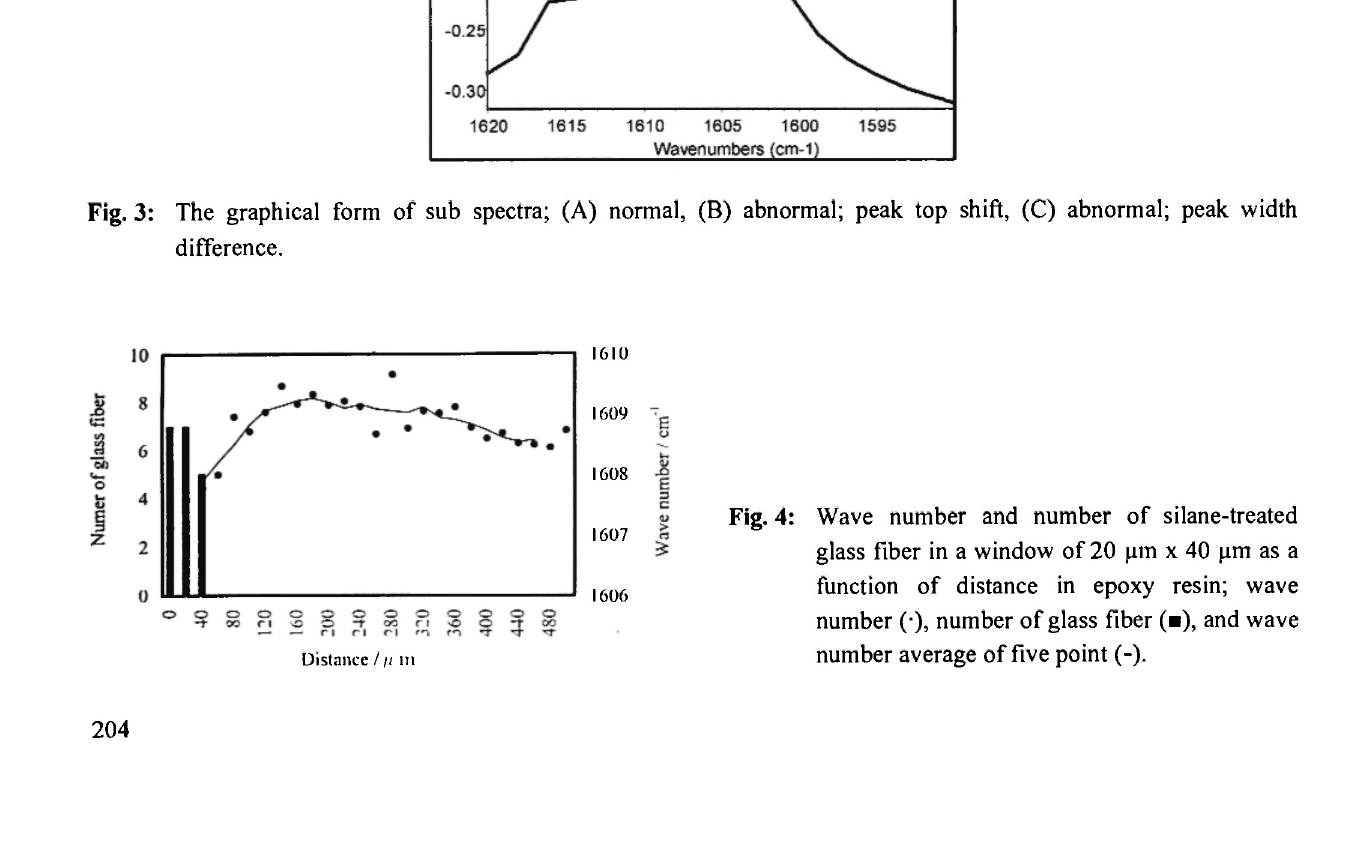
Fig. 3: The graphical form of sub spectra; (A) normal, (B) abnormal; peak top shift, (C) abnormal; peak width difference.